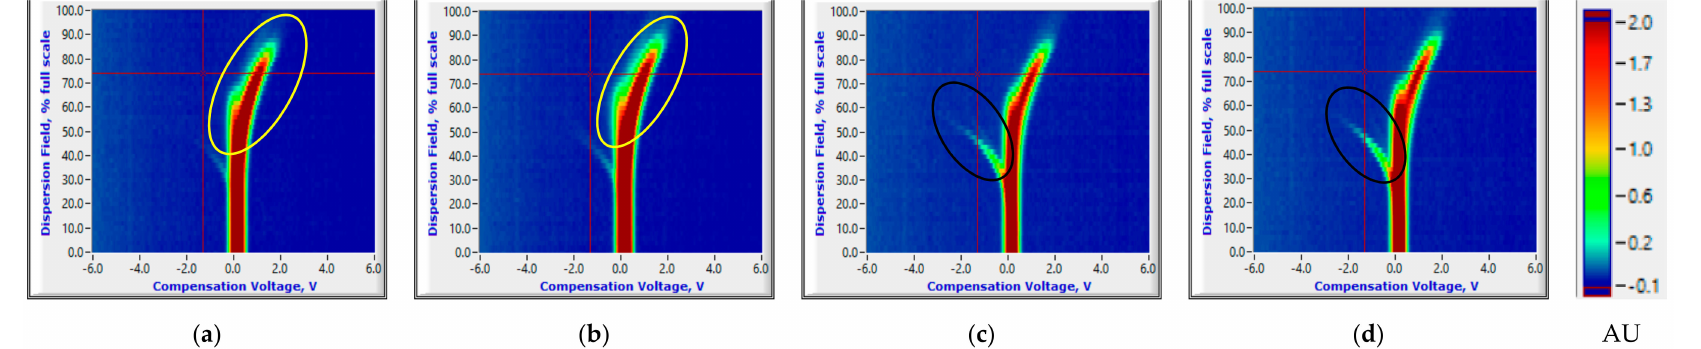
Figure 6. Ion current (AU) plots (corresponds to the color scale) at 0th (healthy control ( a ) and P. ultimum inoculated ( b )) and 15th (healthy control ( c ) and P. ultimum inoculated ( d )) days after inoculation for the Ranger Russet tuber sample replicates stored at reduced temperature (4 ◦ C).